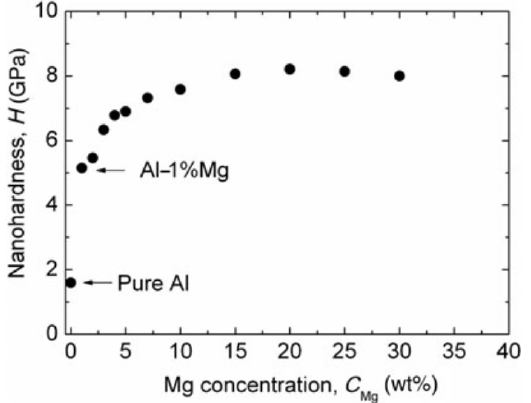
Figure 9. Hardness of the thin AlMg layers as a function of Mg content. Reproduced with permission from [31]. Copyright © 2019, The Materials Research Society.